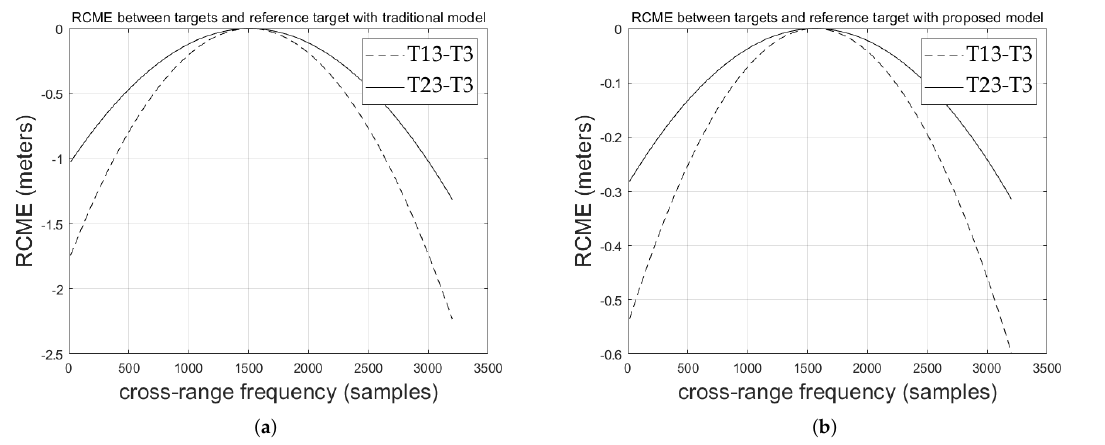
Figure 6. Compensation results of RCM variance of different algorithm along range direction. ( a ) Diagram of the RCME between targets and reference target with traditional model. ( b ) Diagram of the RCME between targets and reference target with proposed